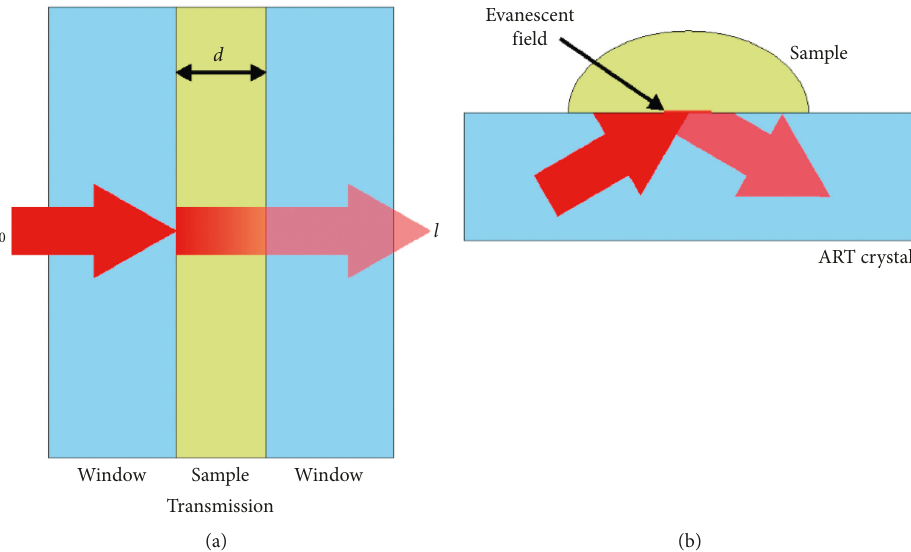
Figure 2: Schematic concepts of transmission and ATR spectroscopy. (a) Transmission. (b) ATR.